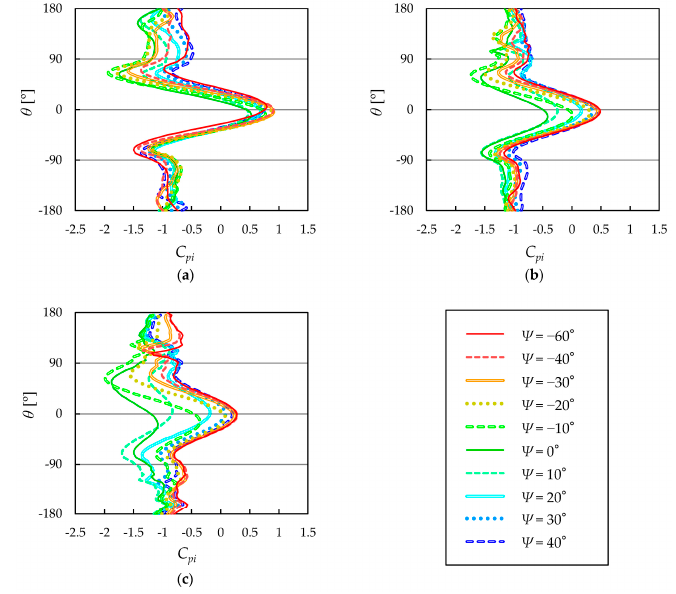
Figure 12. Distributions of the instantaneous pressure coefficient on the tower surface at the mid-height of Segment 4 for moments when the blade nearest the tower is at various Ψ values. ( a ) λ = 3; ( b ) λ = 6; and ( c ) λ = 10.